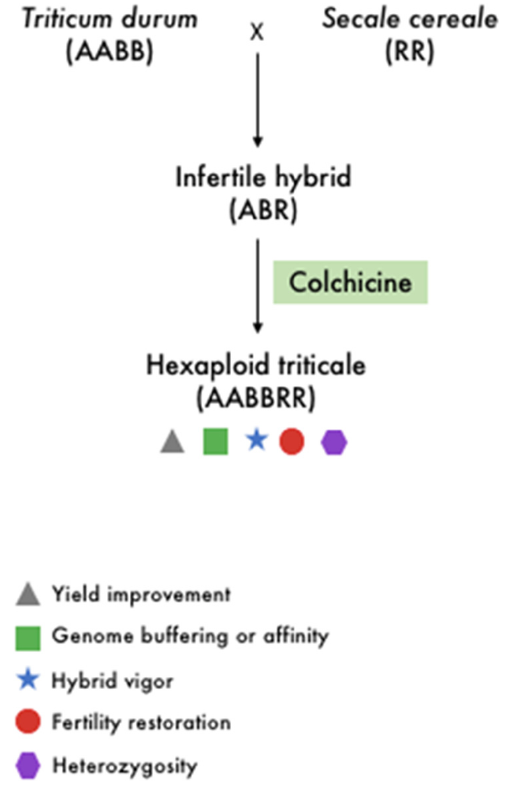
Figure 2. Schematic representation of artificial polyploidy of wheat with some of the main implica- tions of polyploidy in crop improvement.